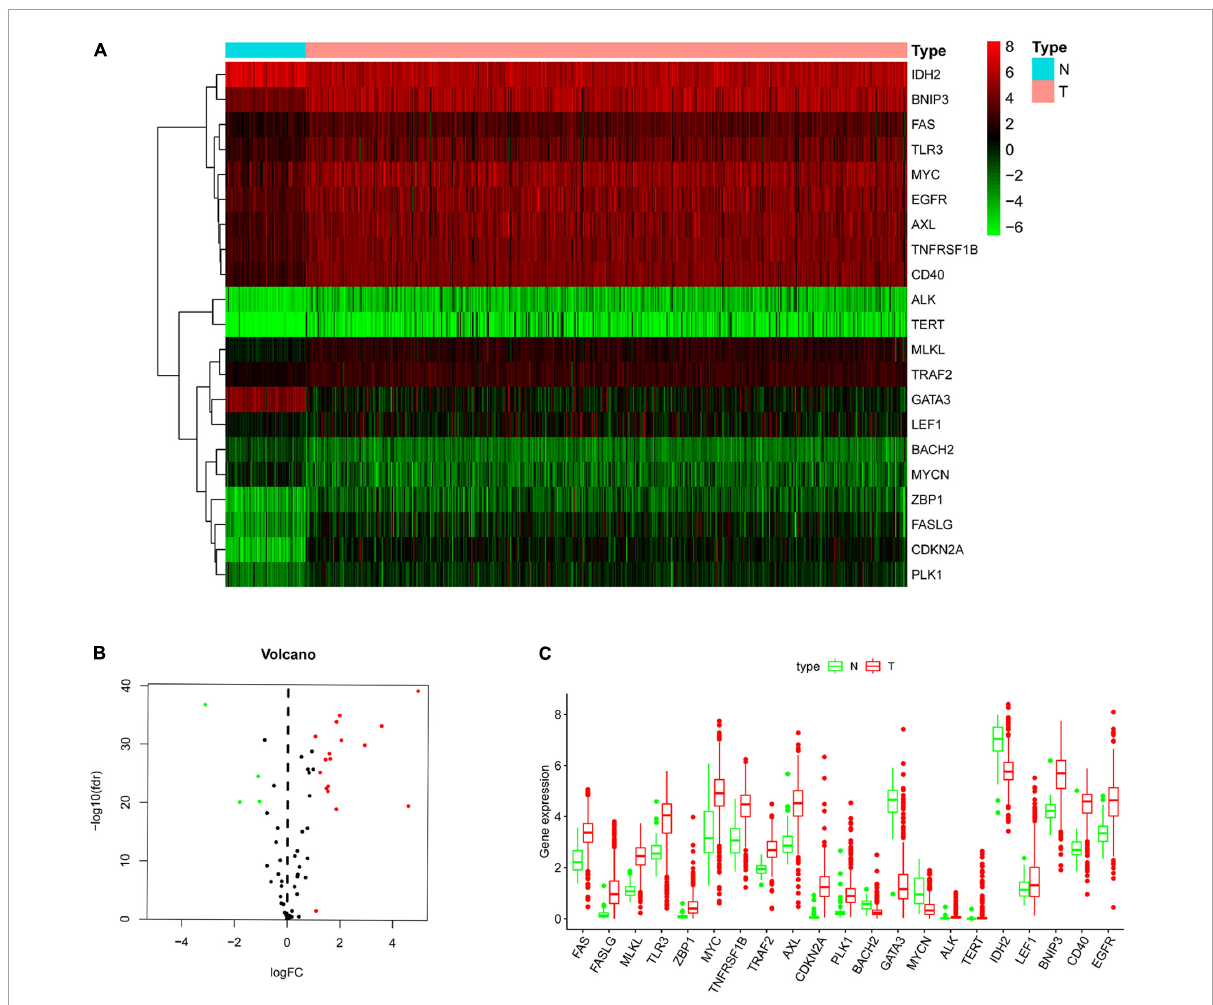
FIGURE1 Differentially expressed NRGs in non-tumor and clear cell renal cell carcinoma (ccRCC) tissues. (A) Heatmap demonstrating 21 differentially expressed genes; (B) volcano map demonstrating 21 differentially expressed genes; (C) box plot of genes in non-tumor and ccRCC tissues. Green and red show non-tumor and tumor tissues,